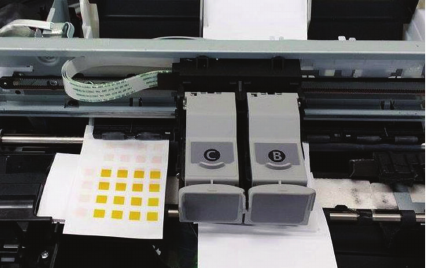
Figure 4: Modified printer with dummy